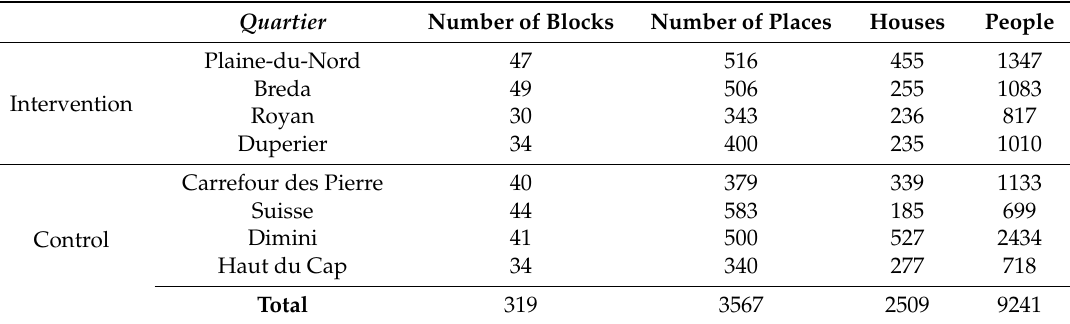
Table 1. Larval Surveillance Mapping